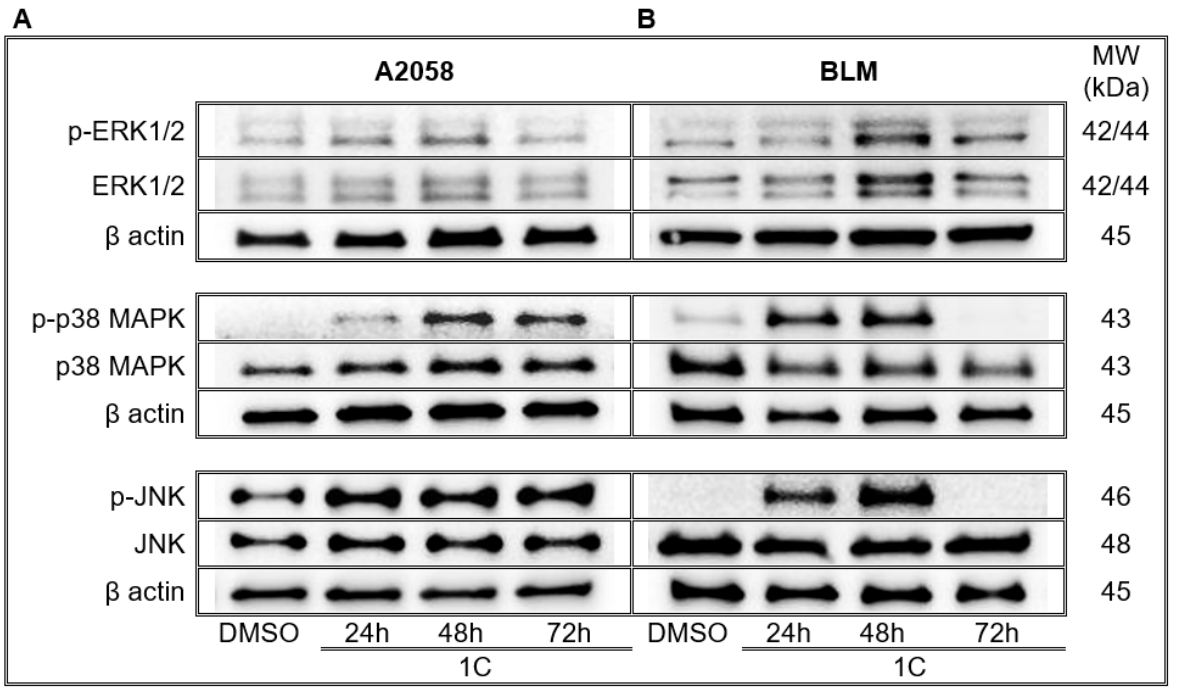
Figure 13. Western blot analysis of ERK1/2, JNK and p38 MAPK signaling pathways in A2058 ( A ) and BLM ( B ) melanoma cells after treatment with chalcone 1C for 24, 48 and 72 h. Representative WB.